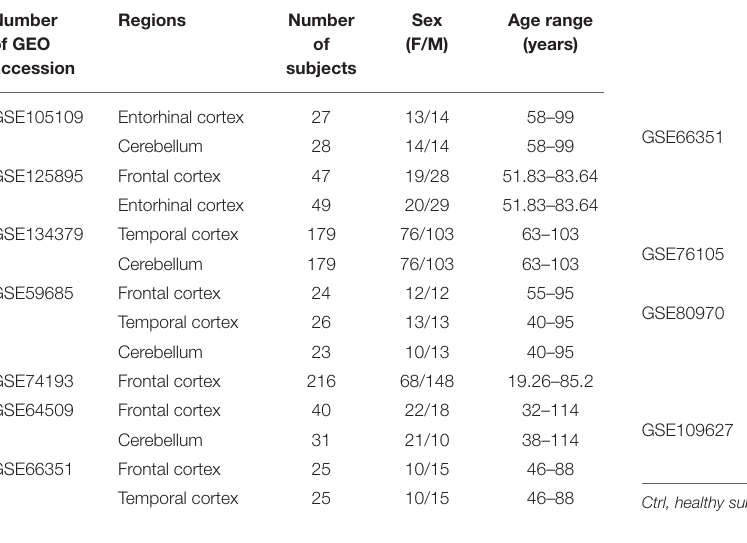
TABLE 1 | Characteristics of the Infinium450k datasets including healthy subjects selected in the present study for the meta-analysis of sex- and age-associated DNAm.